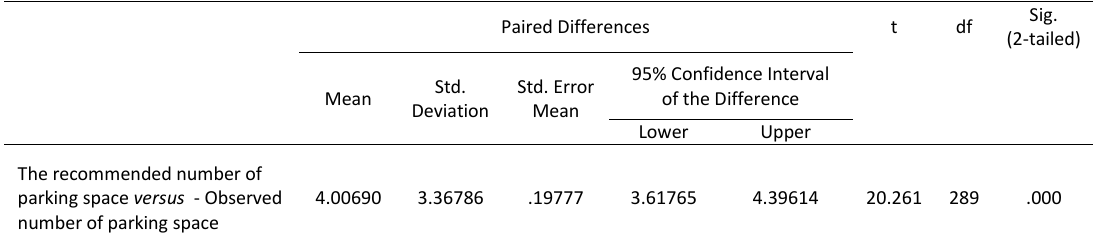
Table 9: Test of Research Hypothesis